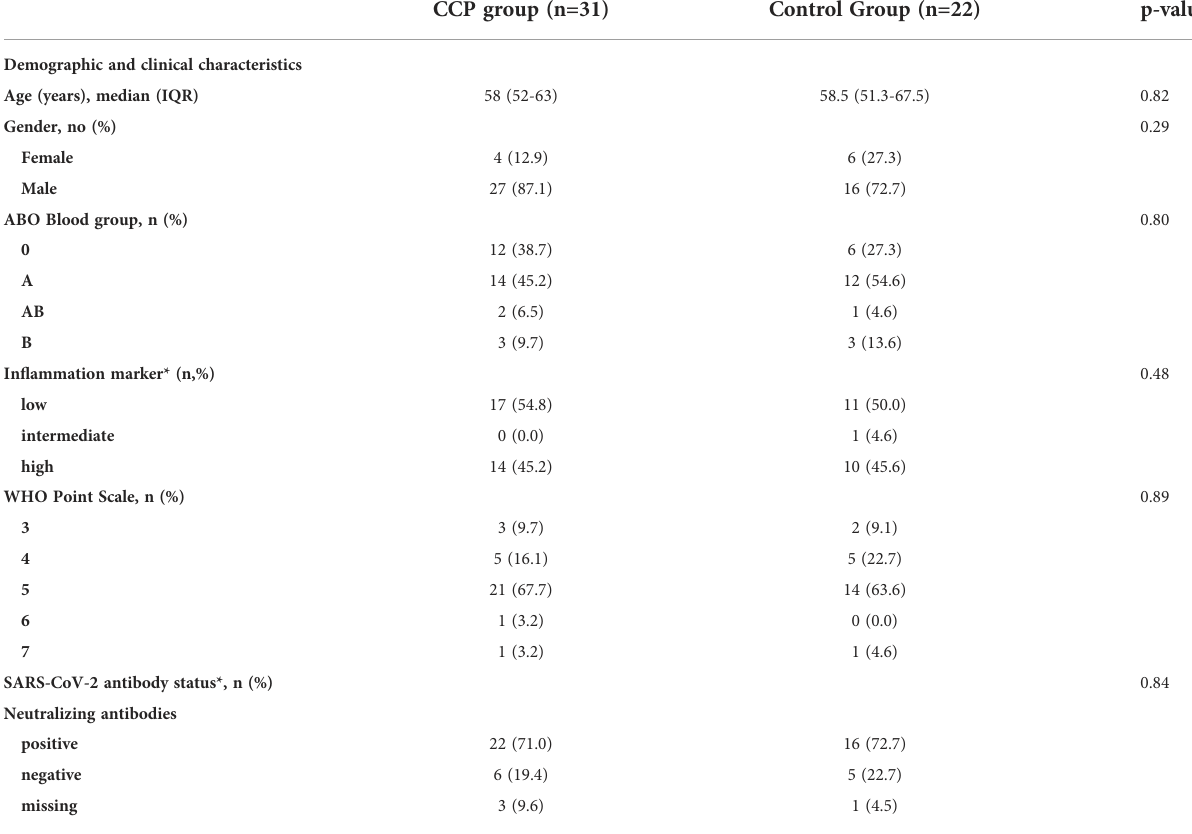
TABLE 1 Baseline demographics and clinical